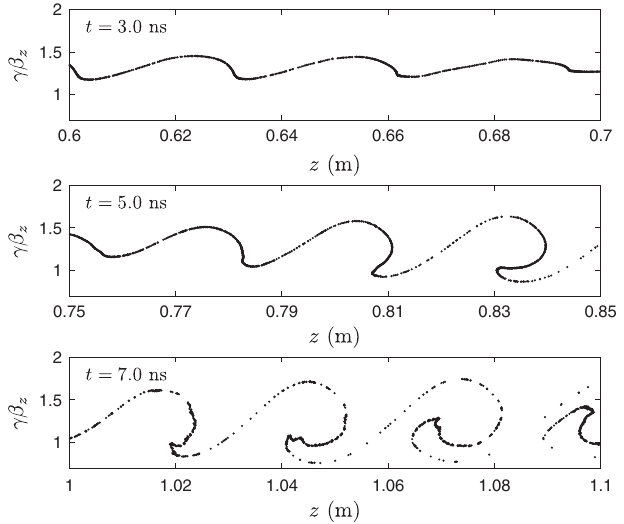
FIG. 23. Trajectory of peak of radiation pulse for a 50 A and a 200 A beam with (cid:1) ¼ 1 from PIC simulations. The group velocity is the inverse slope of the characteristic associated with the peak of the radiation